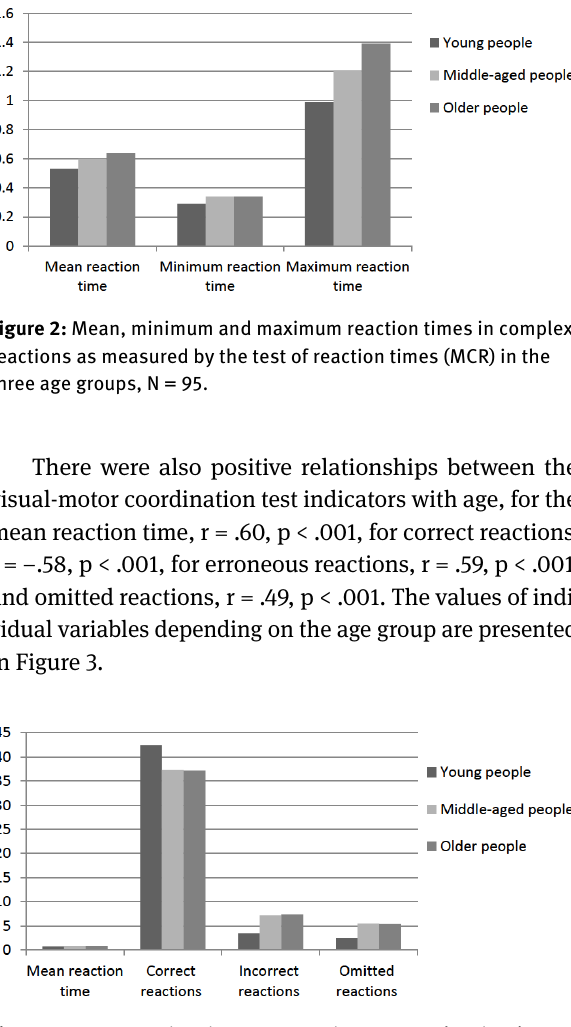
Table 1: The strength of braking processes and the braking start time in base conditions, 1 and 2-back, SURT, N = 95. The strength of braking